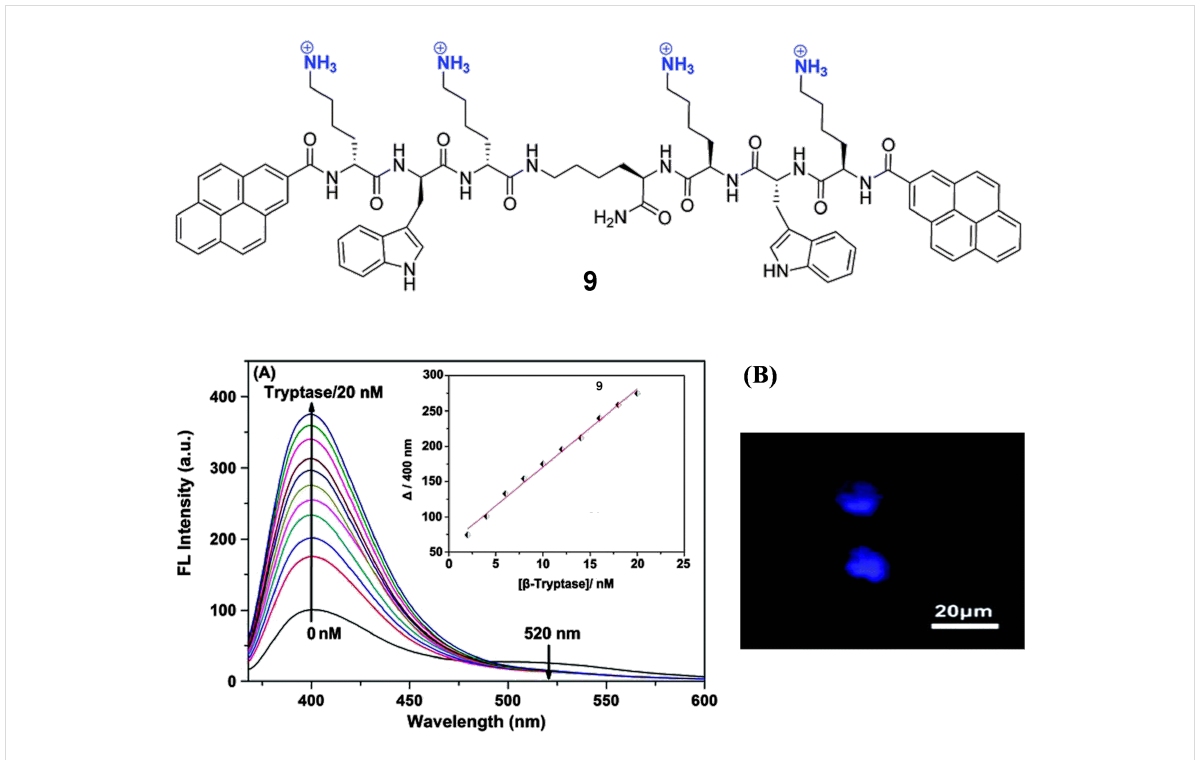
Figure 8: Top: Molecular structure of 9 ; bottom: A) fluorescence response of 9 (500 nM) upon addition of β -tryptase (0–20 nM). Inset: the correspond- ing titration curve showing the increase of the emission at 400 nm with increasing β -tryptase concentration; B) confocal laser scanning microscopy images of CHMAS cells treated with 10 μ M peptide 9 for 30 min. Reproduced from [51], “A fluorescent light-up probe as an inhibitor of intracellular β -tryptase”, © 2014 Wang et al., licensed under a Creative Commons Attribution 3.0 Unported Licence, https://creativecommons.org/licenses/by/3.0/. Published by The Royal Society of